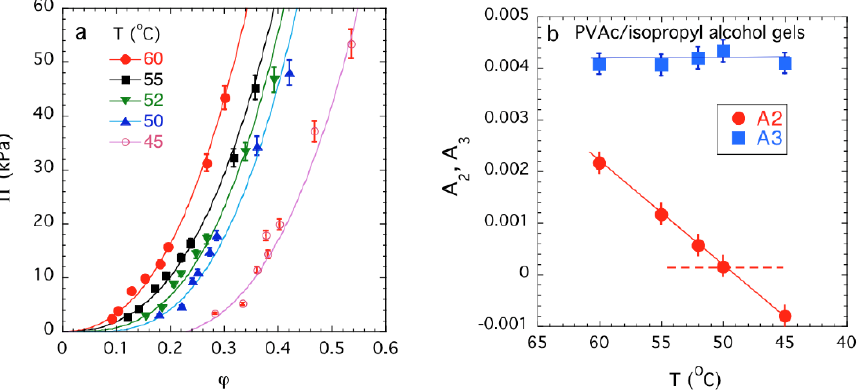
Figure 3. Mixing pressure Π mix versus polymer volume fraction ϕ plots for uncharged polyvinyl acetate (PVAc) gels [50]. The continuous lines show in ( a ) show fits of Equation (4) to the experimental data and the variation of A 2 and A 3 as a function of temperature are shown in ( b ). Note that A 3 is small in magnitude and A 2 changes sign as T varies, signaling the deswelling of the gel. The dotted line indicates A 2 = 0, which defines the theta point condition [6,7]. The data uncertainties are estimated by one standard deviation of the linear regression fit parameters.